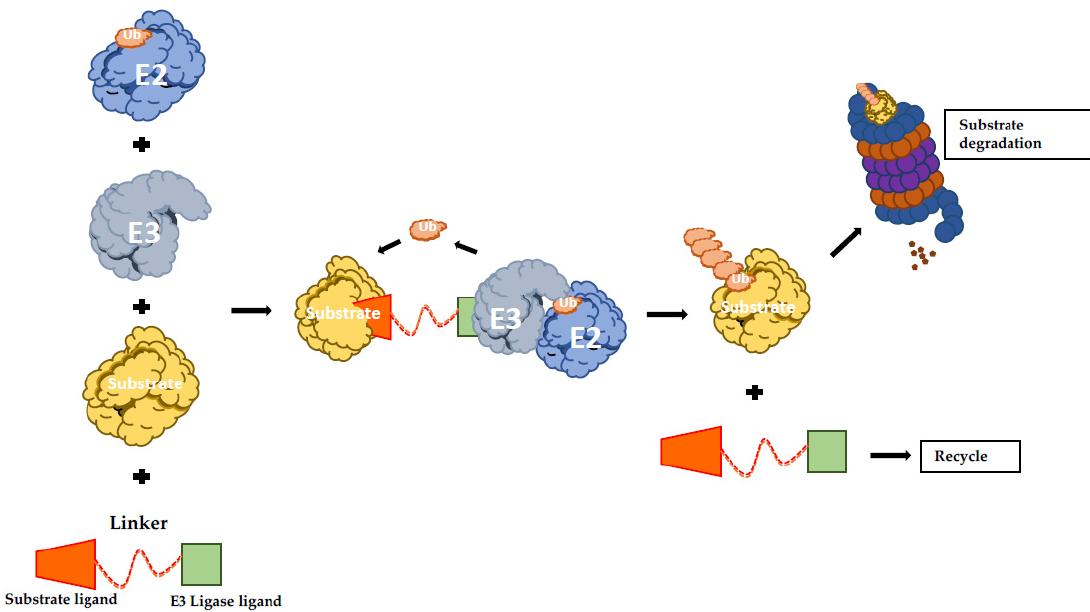
Figure 2. Schematic representation of PROTAC-induced degradation. The bifunctional hybrid molecule binds to both E3 ubiquitin ligase and the target protein. Following E3-mediated ubiquitination, the substrate undergoes UPS-mediated protein degradation. UPS: ubiquitin proteasome system; PROTAC: protein-targeting chimeric molecules.